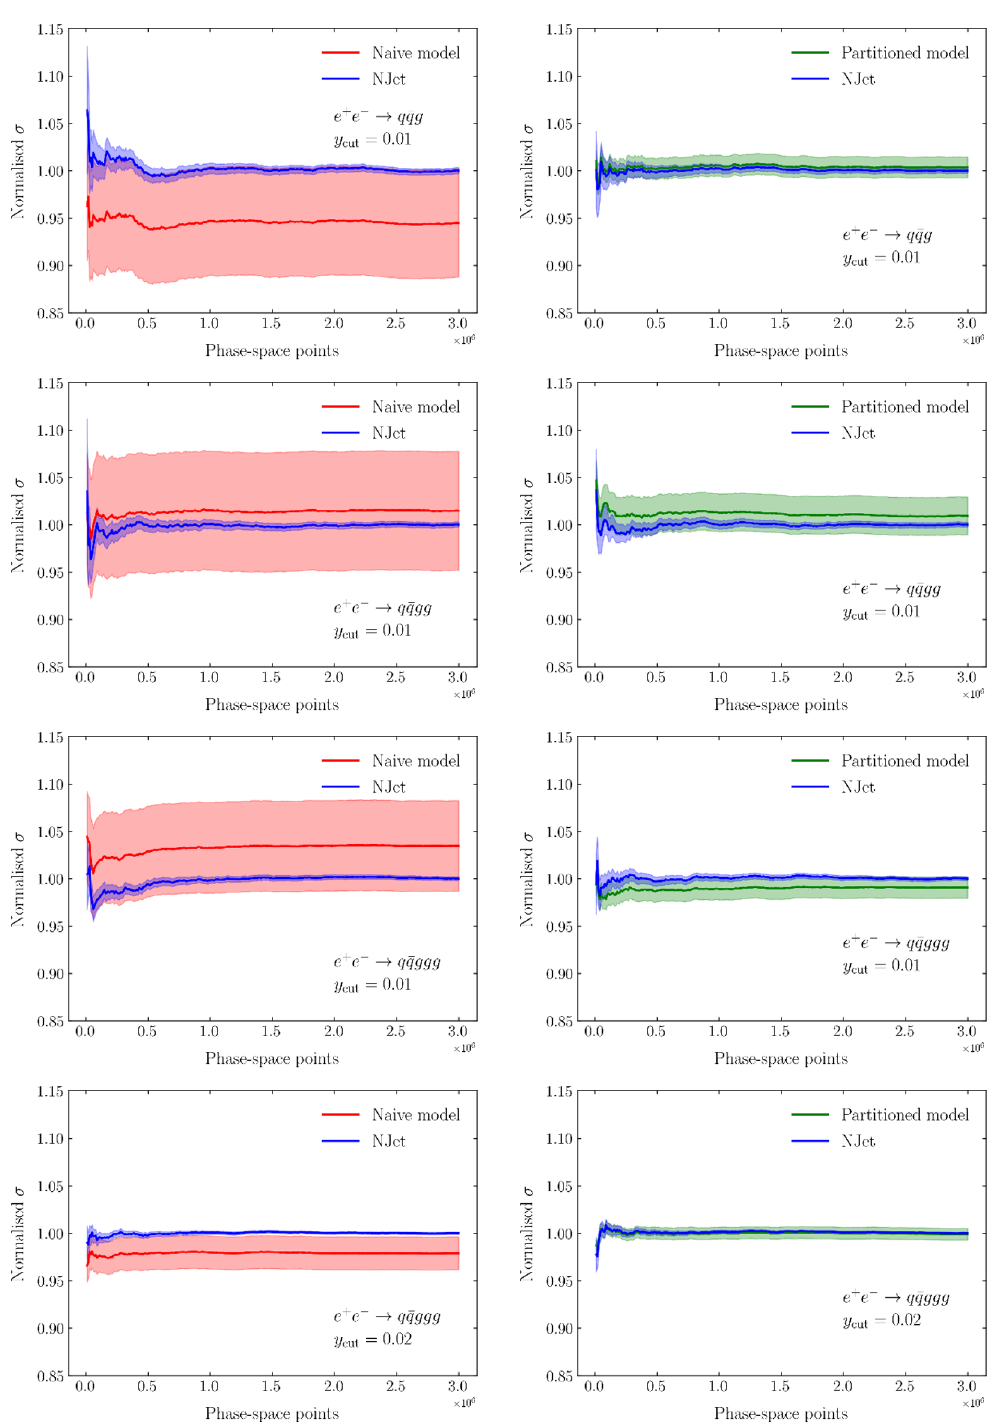
Figure 4 . Comparison of the naive approach (left) vs. the partitioned approach (right) in estimating the Born normalised cross-section. Uncertainty bands denote the standard error on the mean calculated over 20 trained models (red and green) and Monte Carlo error on the Njet result (blue). We refer the reader to section 2.3 for details of the error analysis.